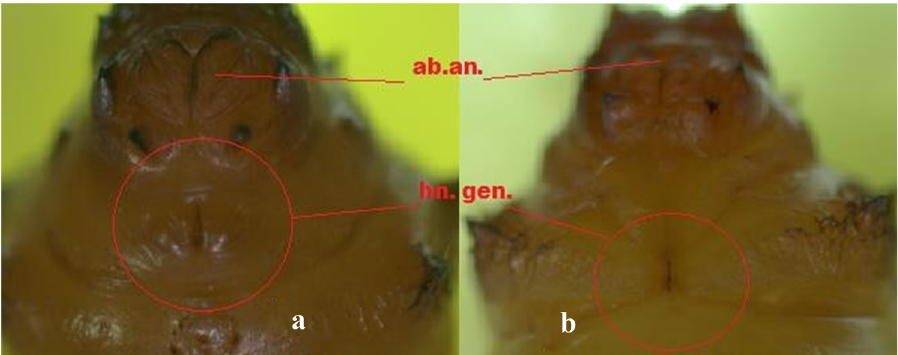
Figure 1: Pupae of D. busckella . ( a ) Terminal of the male pupae. ( b ) Terminal of female pupae. hn.gen. Genital slit; ab.an. Anal opening.